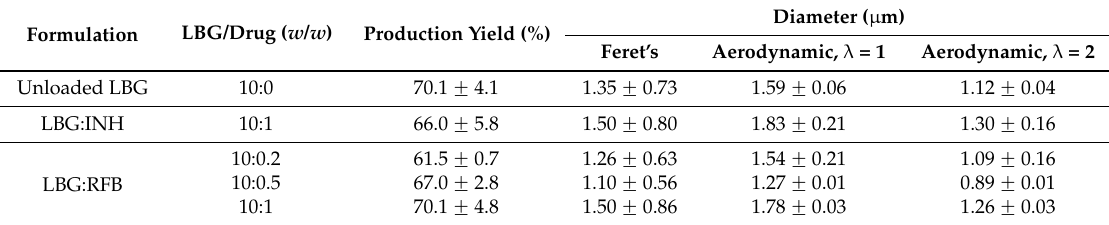
Table 1. Spray-drying production yields and microparticle Feret’s and aerodynamic diameters (mean ˘ SD, n = 3).